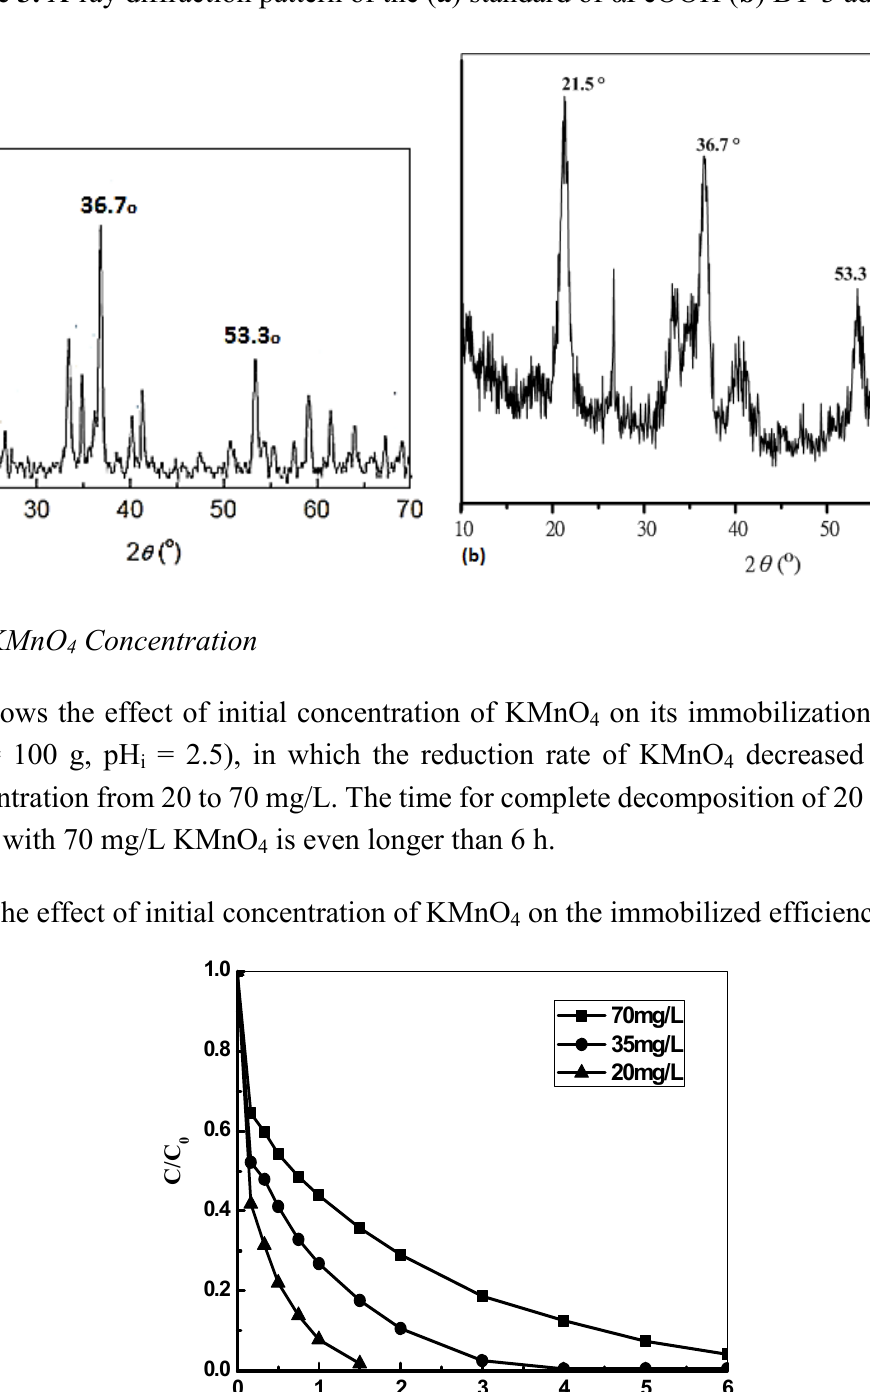
Figure 3. X-ray diffraction pattern of the ( a ) standard of α FeOOH ( b ) BT-3 adsorbent.]